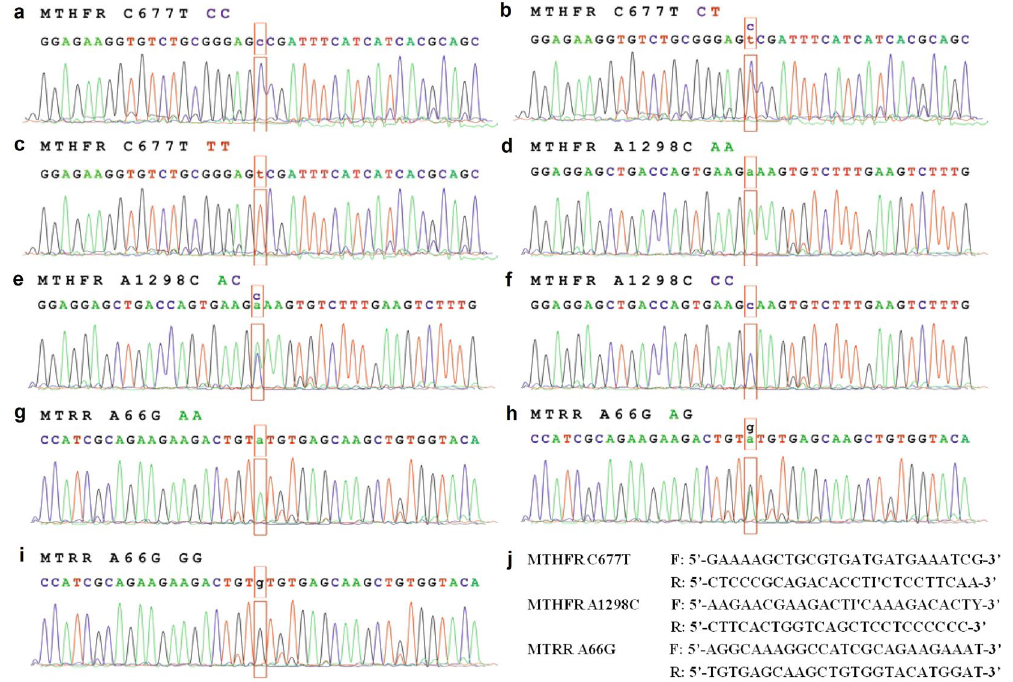
Figure 1. Distribution of MTHFR C677T, A1298C and MTRR A66G genotypes. ( a ) wild-type CC genotype of MTHFR C677T, ( b ) heterozygous CT genotype of MTHFR C677T, ( c ) homozygous mutant TT genotype of MTHFR C677T, ( d ) wild-type AA genotype of MTHFR A1298C, ( e ) heterozygous AC genotype of MTHFR A1298C, ( f ) homozygous mutant CC genotype of MTHFR A1298C, ( g ) wild-type AA genotype of MTRR A66G, ( h ) heterozygous AG genotype of MTRR A66G, ( i ) homozygous mutant GG genotype of MTRR A66G, ( j ) the primers of MTHFR and